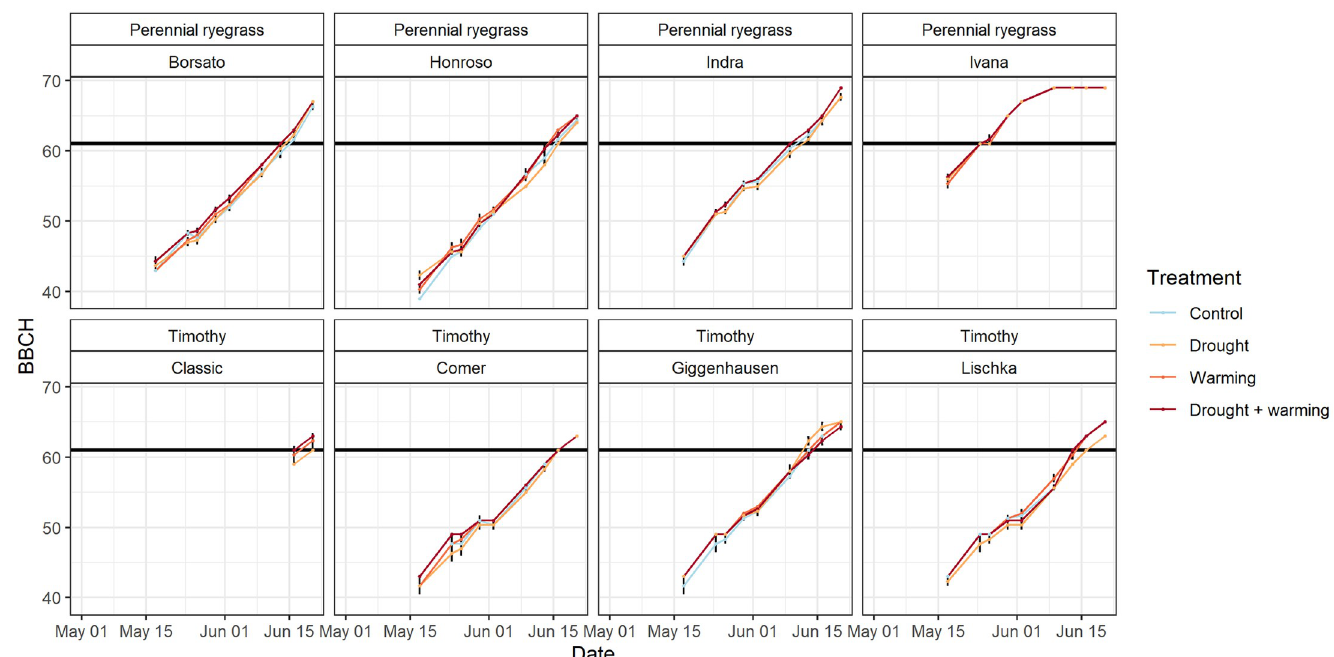
Fig 3. Phenological development of the cultivars for perennial ryegrass and timothy in spring 2017. BBCH indicates the (micro-) stages according to BBCH code [35] between May 17 and June 23, 2017. Black lines indicate the beginning of flowering (BBCH 61), parts of the data is missing for the cultivar Classic before its recovery (see Methods 2.1).